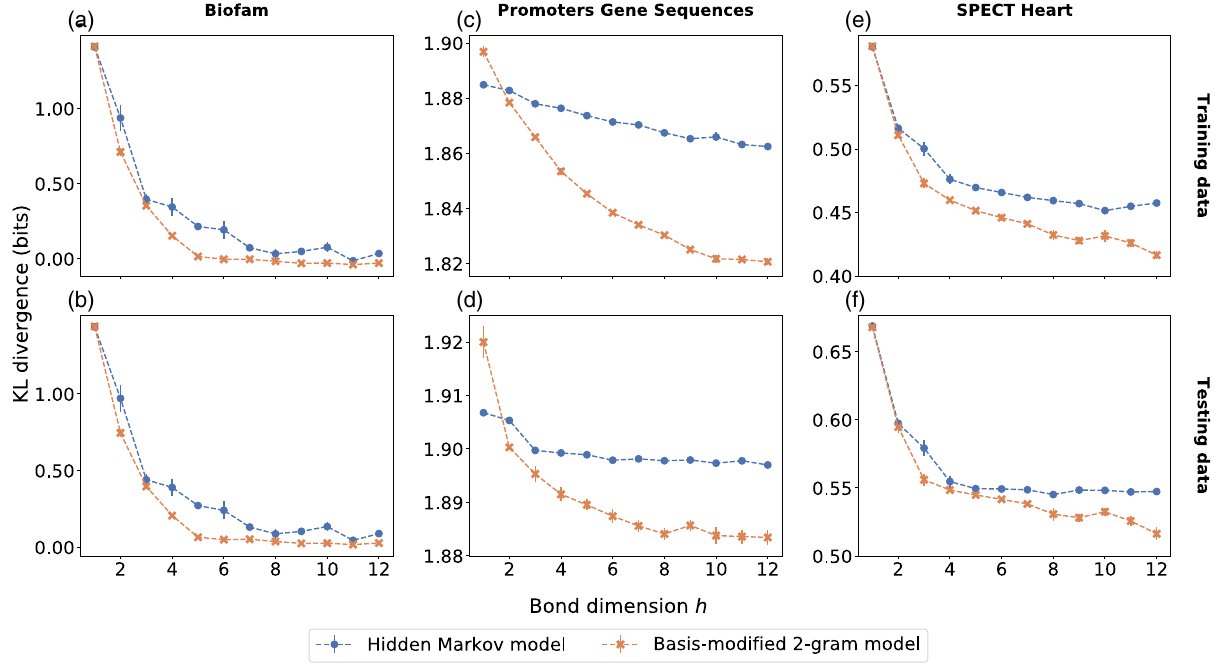
FIG. 13. Average performances over ten trials of the classical HMM (blue circles) and the basis-enhanced 2-gram model (orange crosses) on (a,b) the biofam, (c,d) Promoter Gene Sequences, and (e,f) SPECT Heart data sets. The first row plots the performance on the training data, and the second the performance on the withheld testing data. The basis-enhanced 2-gram model, on average, performed better than the classical model even on the simple biofam data set, implying more consistent performance in the basis-enhanced 2-gram model. Error bars denote 1 standard error of the mean over ten trials. Dashed lines are to aid the